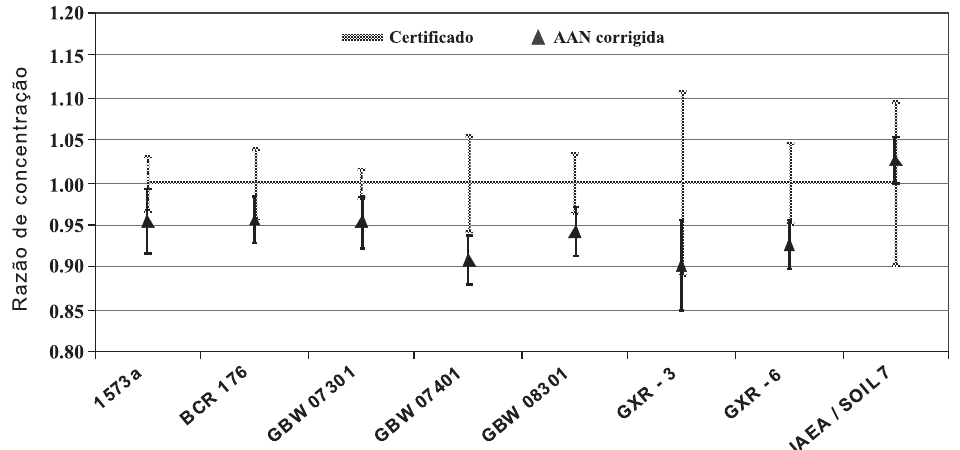
Figura 3. mn: comparação entre os valores experimentais corrigidos e os valores certificados. as barras verticais são as incertezas associadas.